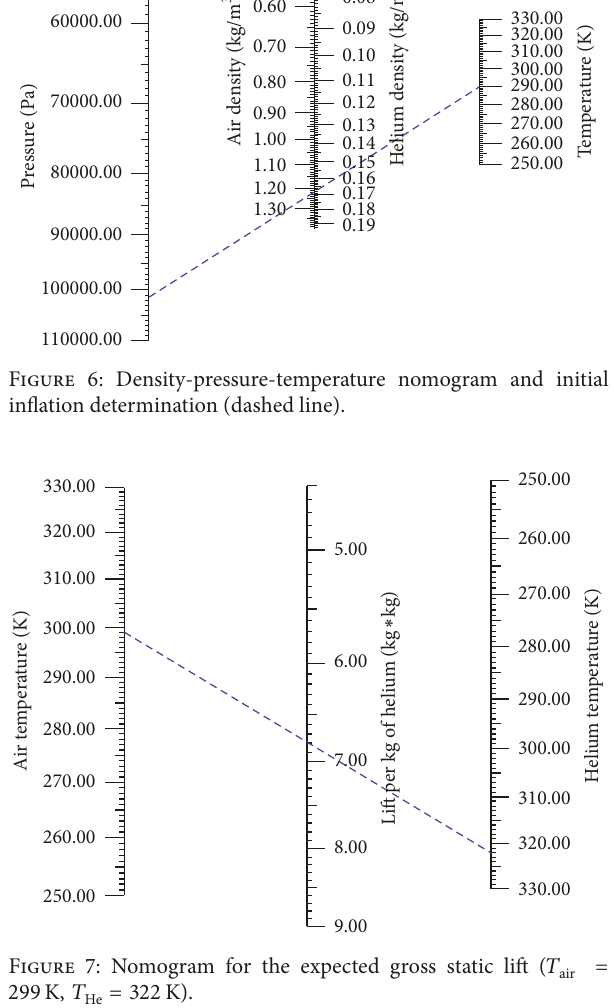
Figure 7: Nomogram for the expected gross static lift ( 𝑇 299 K, 𝑇 = 322 He